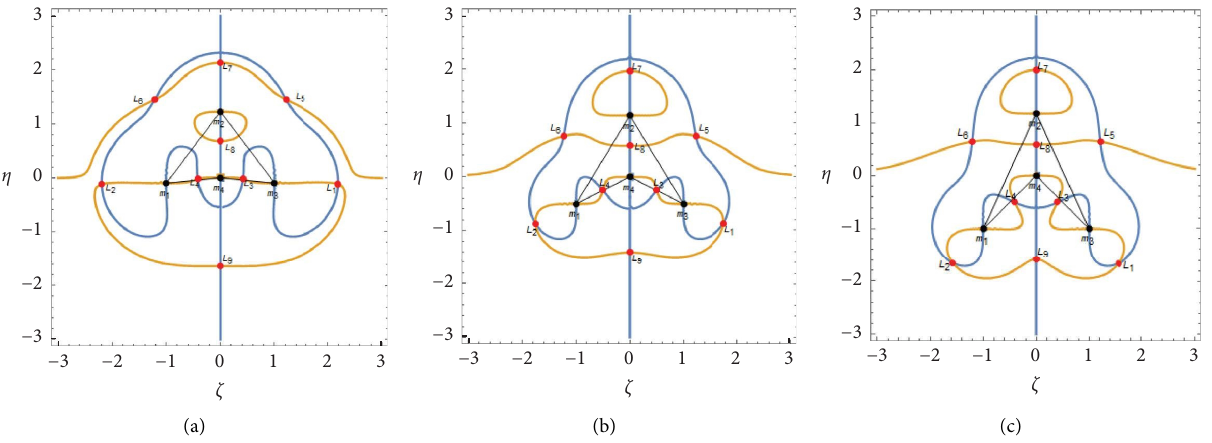
Figure 18: Case II: (a) α � 0 . 1, μ � 2 . 30816, (b) α � 0 . 5, μ � 1 . 02436, (c) α � 1, μ � 1 .